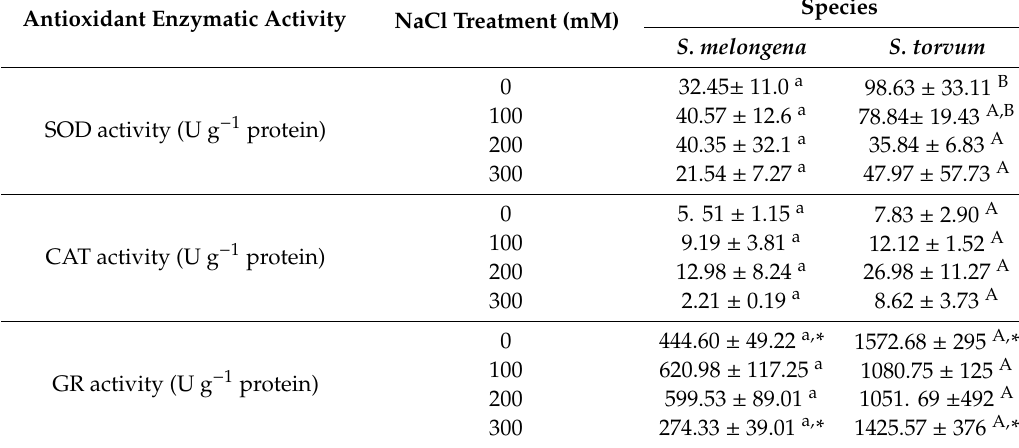
Table 9. Activity of the antioxidant enzymes, superoxide dismutase (SOD), catalase (CAT), and glutathione reductase (GR) (mean ± SE, n = 5) in foliar tissue of Solanum melongena and S. torvum plants after 25 days of salt treatments with the indicated NaCl concentrations Antioxidant Enzymatic Activity NaCl Treatment